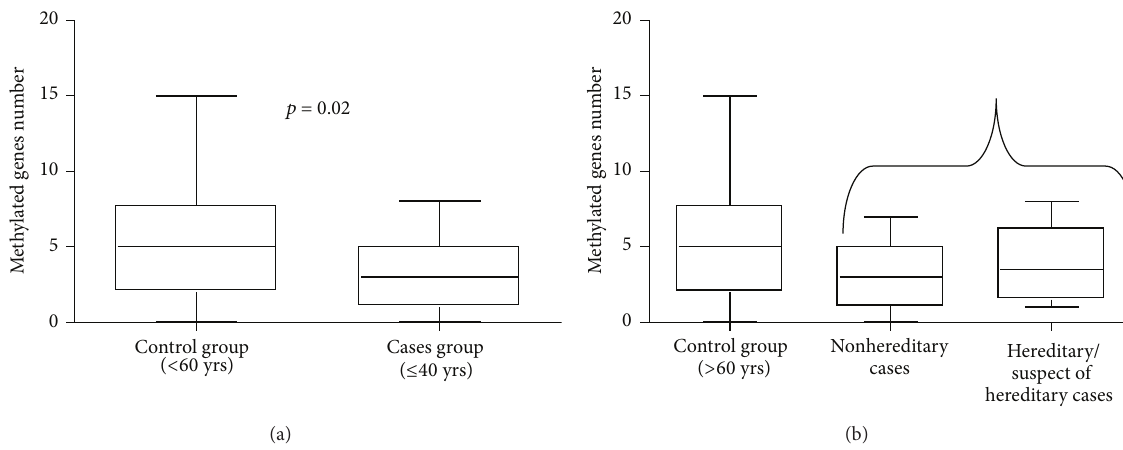
Figure 1: Results of methylation status in young group and in elderly group. In (a), we observed a significant difference in methylation pattern between patients under 40 yrs and patients over 60 yrs. The mean number of methylated genes in the control group is higher than average number in the cases group. In (b), we observe no statistical difference between control, young, and hereditary cases, but the difference remained significant between patients under 40 yrs and patients over 60yrs.